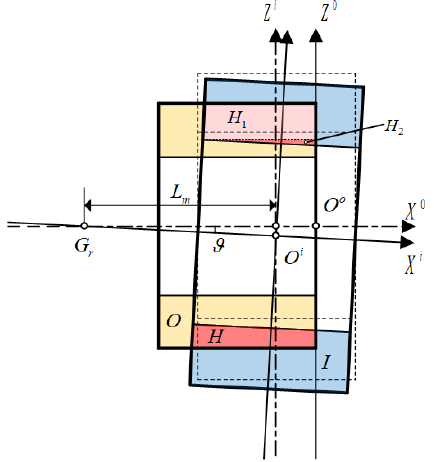
Figure 5. The meshing model of Angular Misaligned Gear Coupling (AMGC).